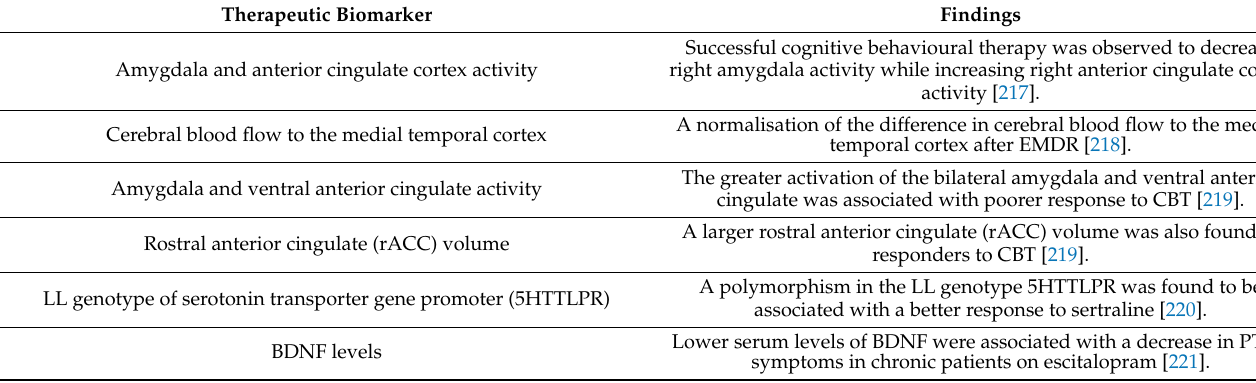
Table 4. Summary of the therapeutic biomarkers implicated in